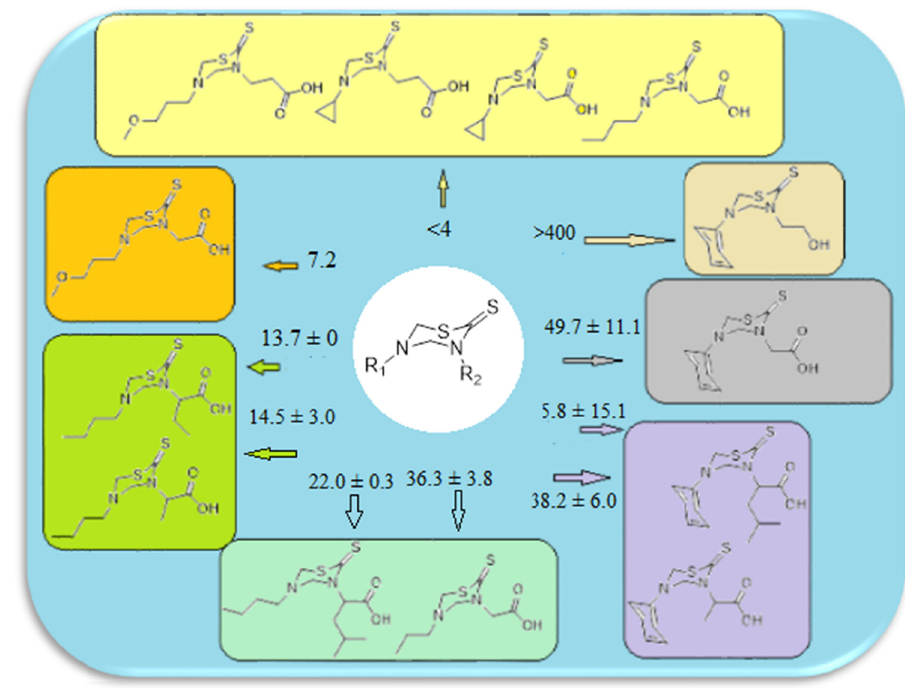
Figure 1: Structural diversity and IC 50 – a schematic